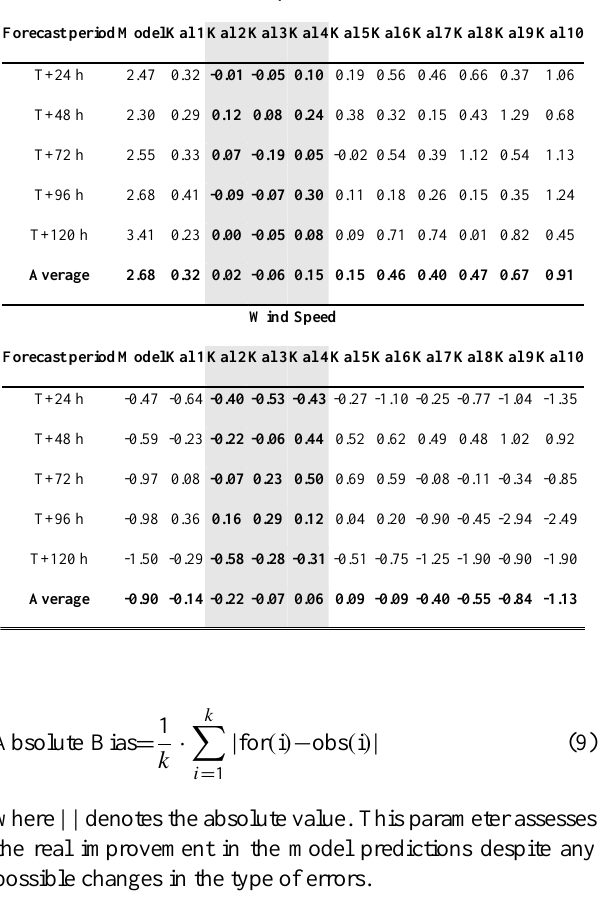
Table 1. Biases of direct model output and Kalman filters – Case I. TABLE 1. Biases of direct model output and Kalman filters – Case I Temperature